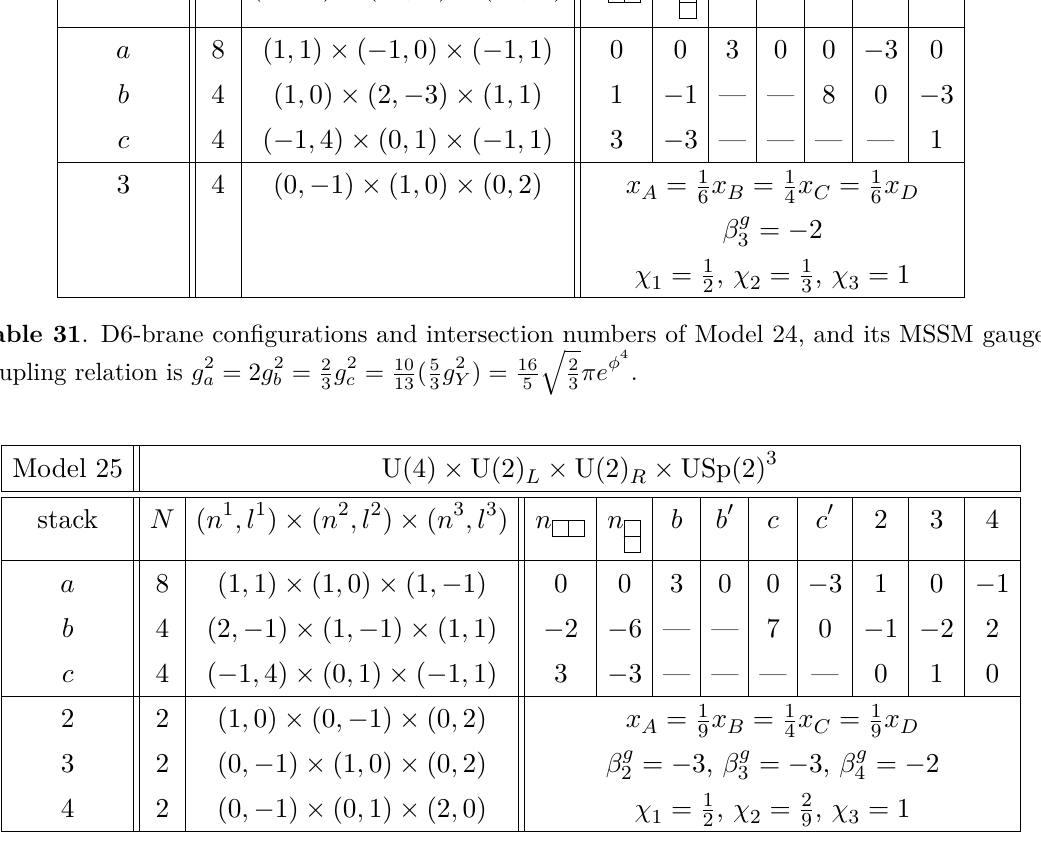
Table 32 . D6-brane configurations and intersection numbers of Model 25, and its MSSM gauge